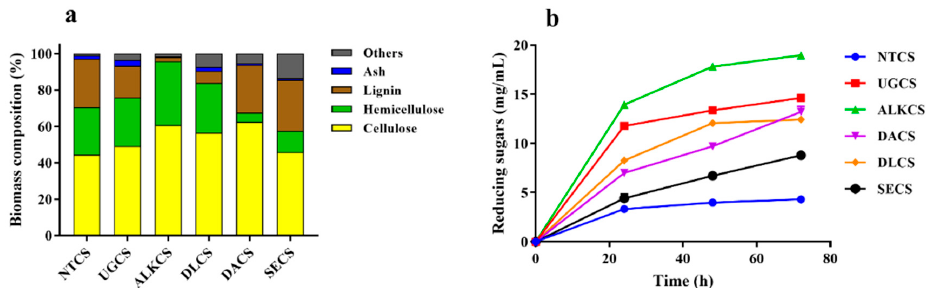
Figure 5. Reducing sugar yield from differently pre-treated fractions of corn stover by T. harzianum EM0925 enzyme cocktail. ( a ) Chemical compositon of pretreated corn stover. NTCS, matural corn